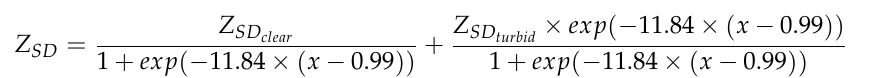
Figure 5. Function diagram of coefficients of QAA_clear after bringing in the